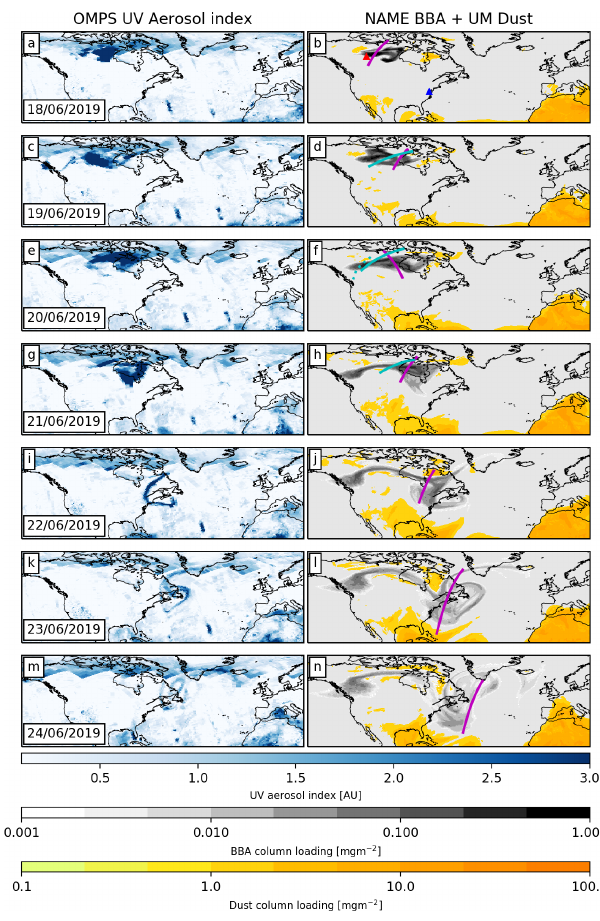
Figure 6. Left-hand column: daily composites of OMPS UV aerosol index. Right-hand column: simulated column loadings for BBA (black – mgm − 2 ) and UM dust column loadings (yellow – mgm − 2 ) for 12:00UTC on the date shown. The source location for simulated BBA particles is shown in the uppermost right-hand panel as a red triangle, and the location of the Washington MPL li- dar station is shown as a blue triangle. In the right-hand panels a selection of CALIPSO overpasses are marked in magenta, and four CARIBIC flight tracks are marked in